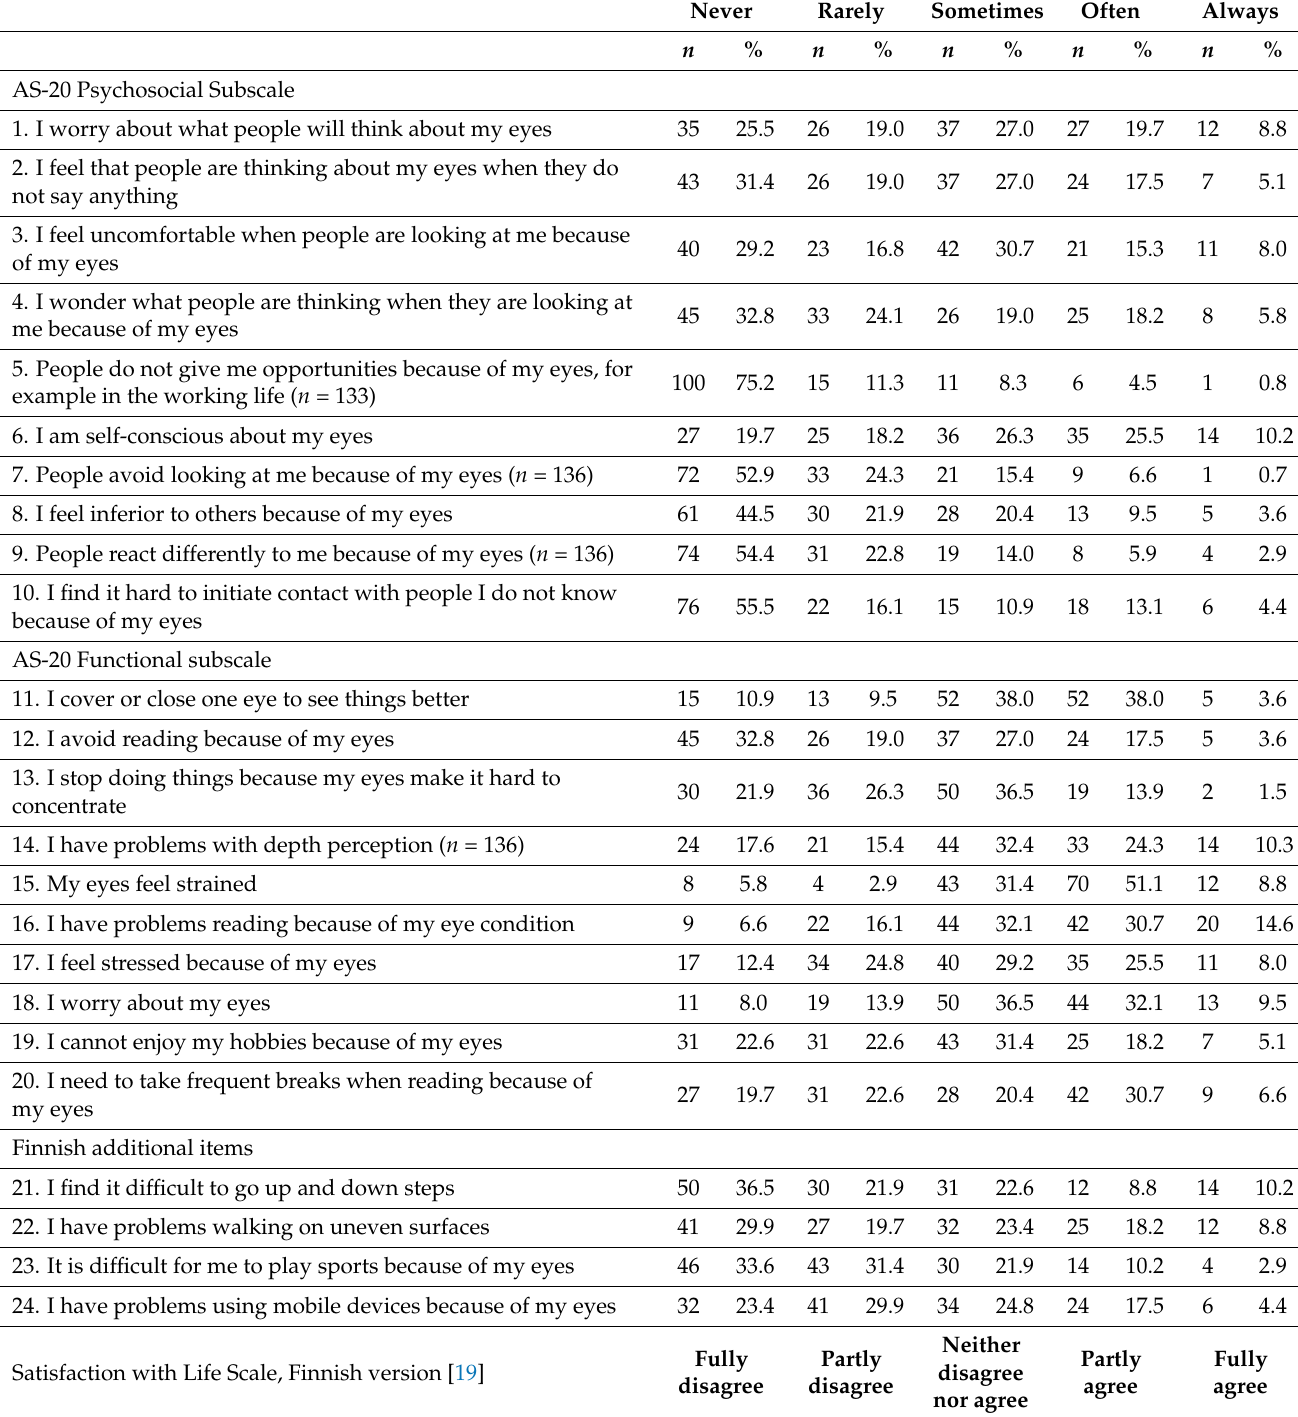
Table 2. Frequencies and percentages of participants’ responses to the translated Adult